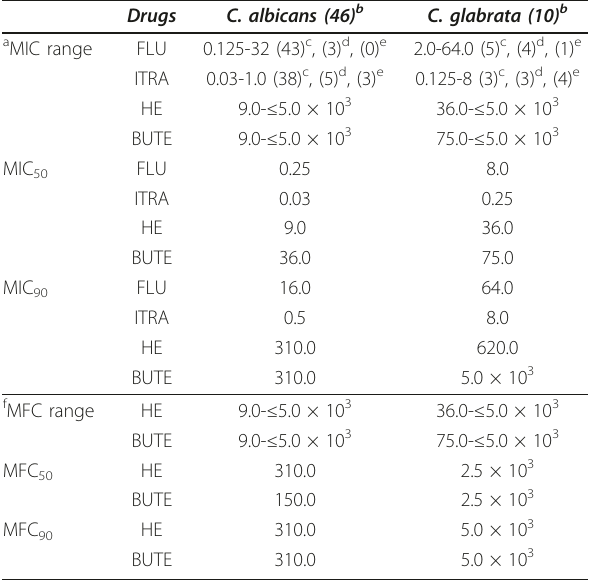
Table 1 Anti- Candida activity in vitro of the hydroalcoholic (HE) and butanolic (BUTE) extracts of Sapindus saponaria in comparison to fluconazole (FLU) and itraconazole